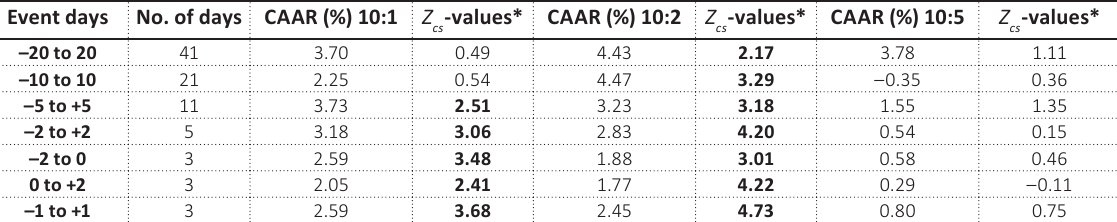
Source: Calculated by the authors based on the Prowess IQ database.